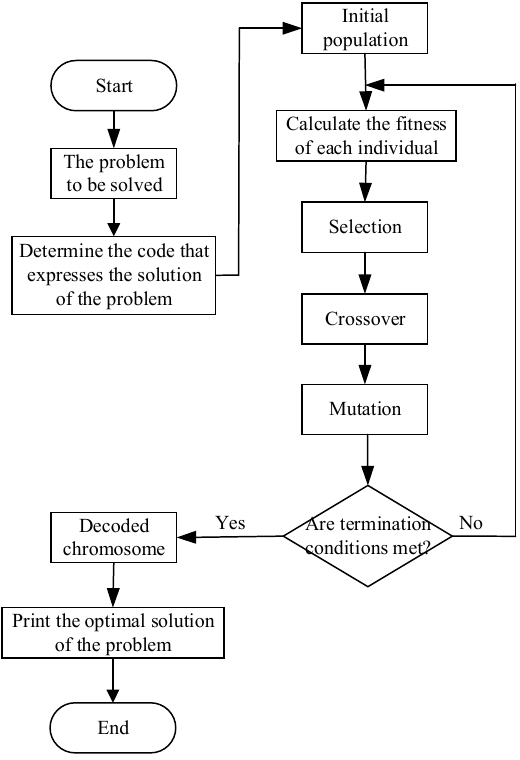
Figure 2. Flowchart of a simple genetic algorithm.